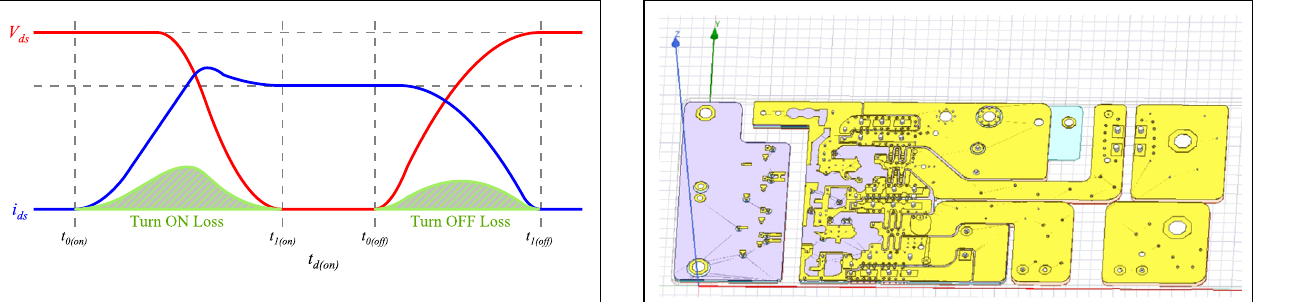
FIGURE 5 | Q3D model of the PCB